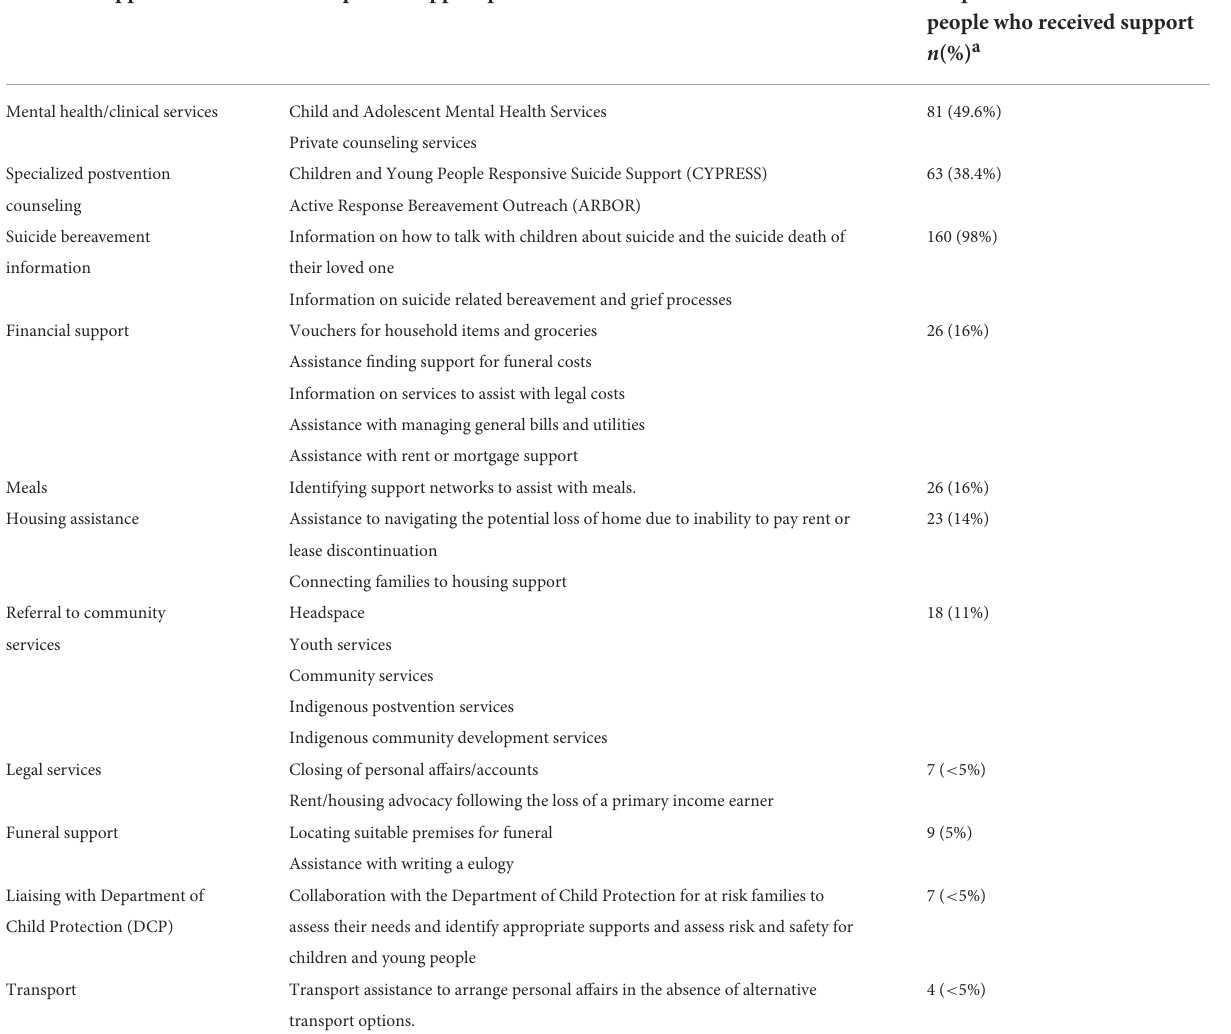
TABLE 4 Description and frequency of support provided to bereaved people in the PaRK